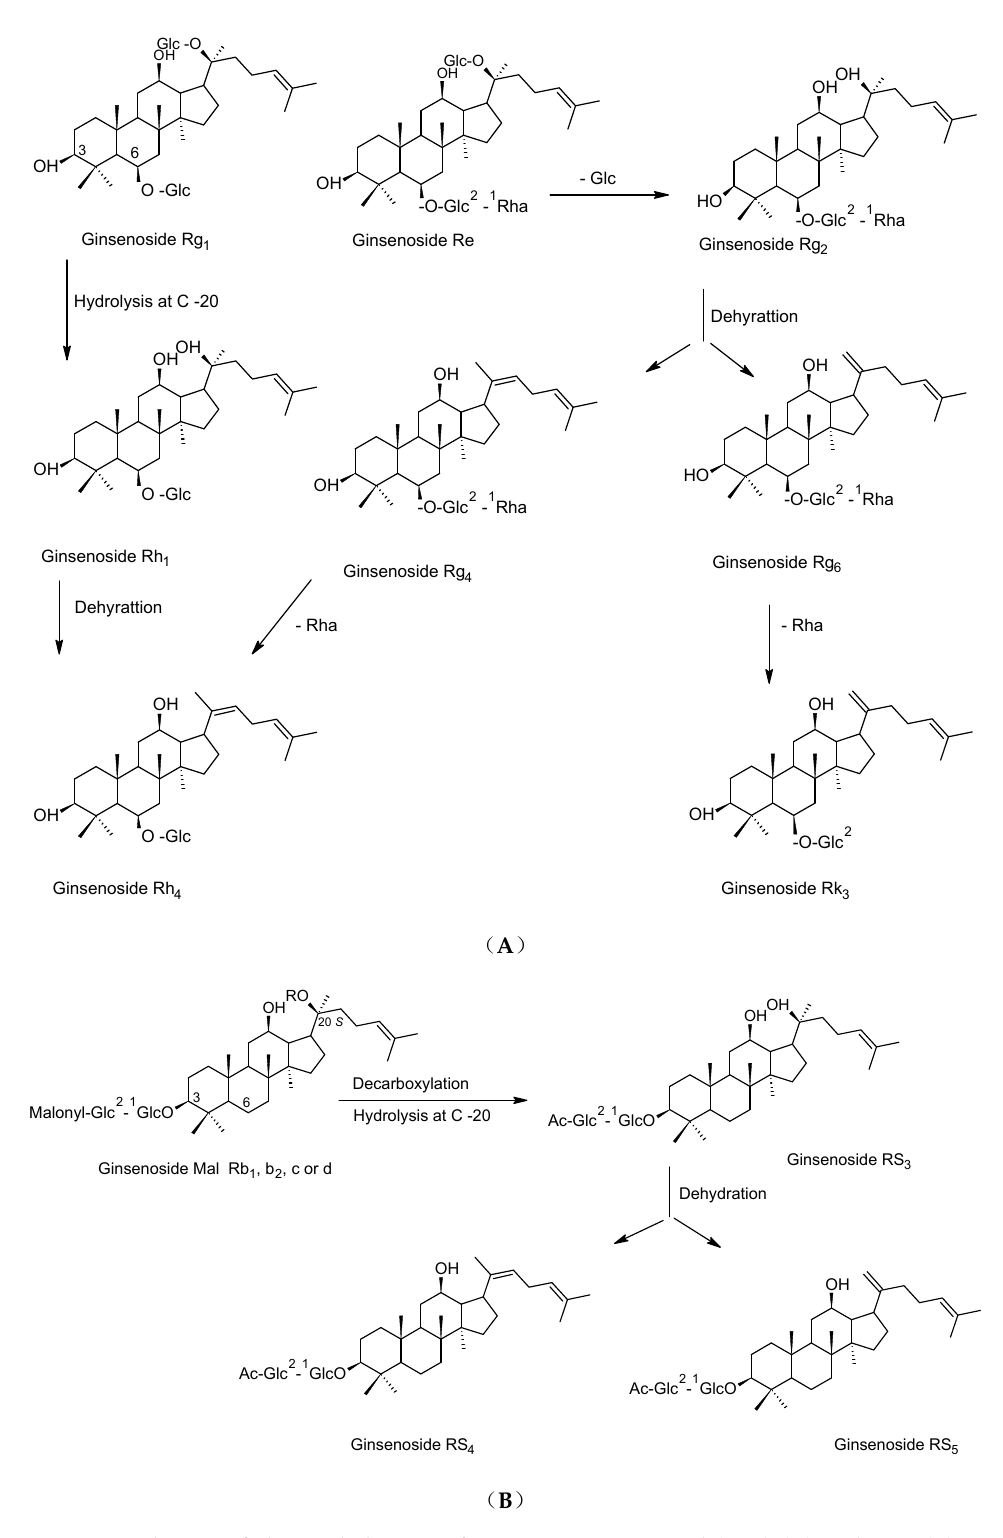
Figure 3. Pathways of chemical changes of some protopanaxatriol (PPT) ( A ) and PPD ( B ) type ginsenosides during black ginseng